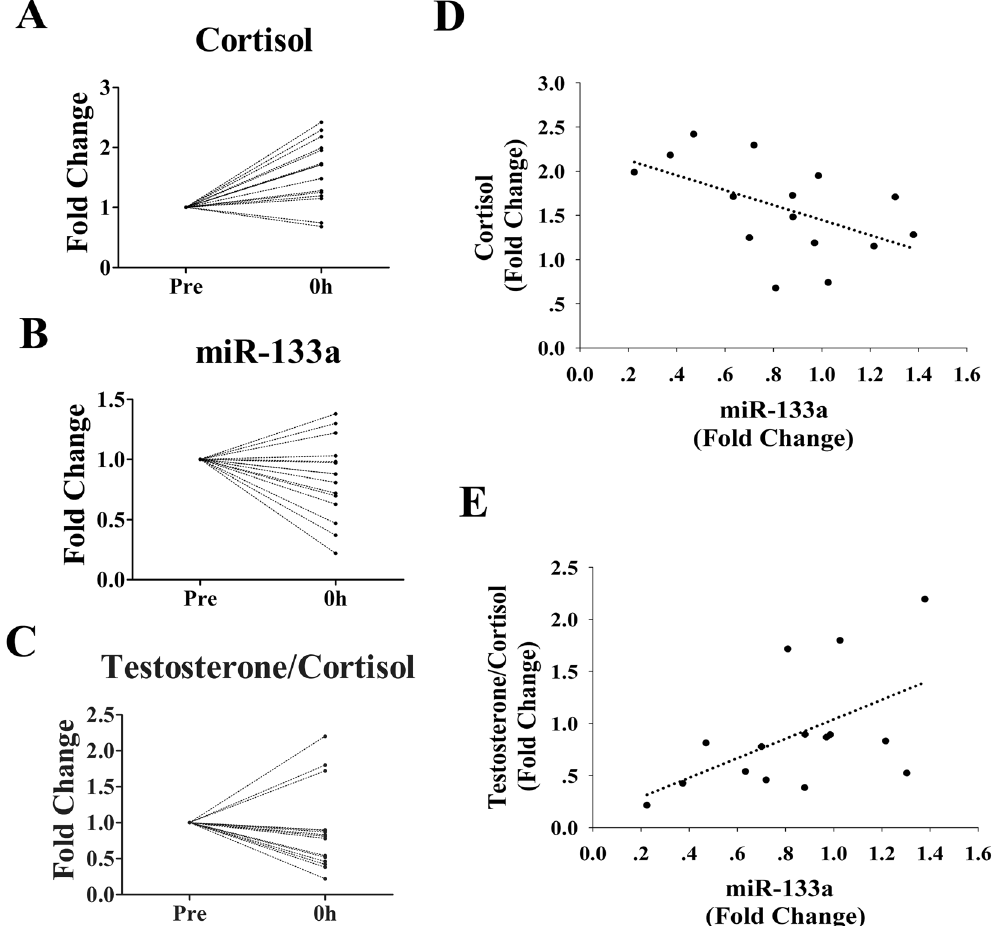
Figure 7. Correlations of miR-133a with plasma cortisol and testosterone/cortisol levels (n = 15). For each subject, the plasma levels of miR-133a, cortisol and testosterone at baseline (Pre) were assigned a fold change of 1, and measurements obtained immediately after exercise (0 h), after 1 h of recovery (1 h) and after 24 h of recovery (24 h) were compared to the baseline. Scatterplots show the plasma levels of cortisol ( A ), miR-133a ( B ) and testosterone/cortisol ( C ). A direct correlation is observed between plasma levels of miR-133a and cortisol ( D ) and testosterone/cortisol ( E